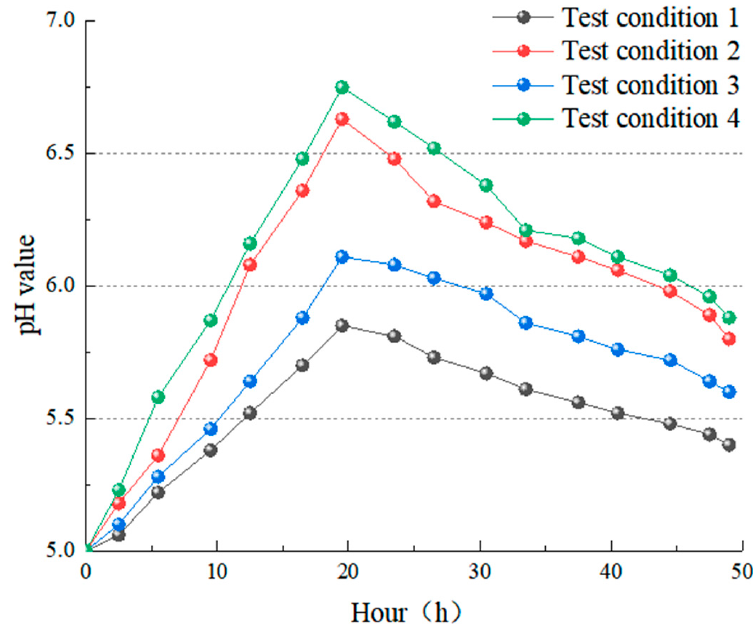
Figure 13. The curve of change of pH value during the test.